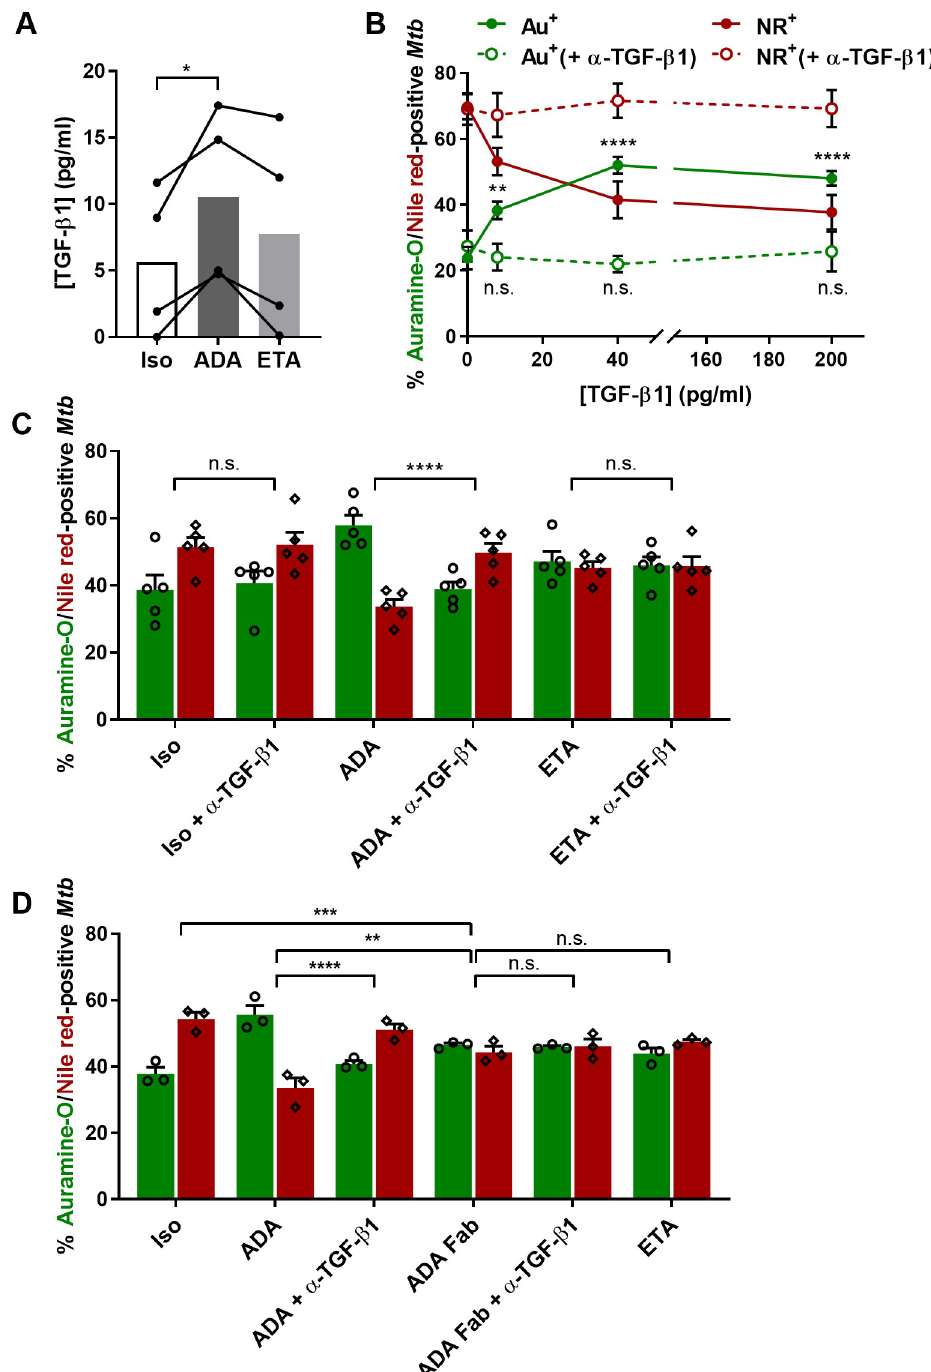
Fig 5. ADA specifically mediates TGF- β 1-dependent Mtb resuscitation. (A) Active TGF- β 1 concentration in supernatants of granulomas 8 days post-infection with Mtb H37Rv and after 4 days of exposure to either adalimumab (ADA), etanercept (ETA) or an isotype control (Iso) (values for 4 independent donors are represented by line- connected circles and bars depict mean concentration). Statistical analysis was performed using Friedman test. (B-D) Averaged percentages of auramine-O- (green) and Nile red-positive (red) Mtb quantified by fluorescence microscopy after 4 days of exposure to: (B) 0, 8, 40 or 200 pg/ml of recombinant TGF- β 1 in the absence (full circles/continuous line) or presence (open circles/dotted line) of a TGF- β 1-blocking antibody (mean ± SEM from 3 independent donors); (C) an isotype control (Iso), adalimumab (ADA), or etanercept (ETA) in the absence or presence of a